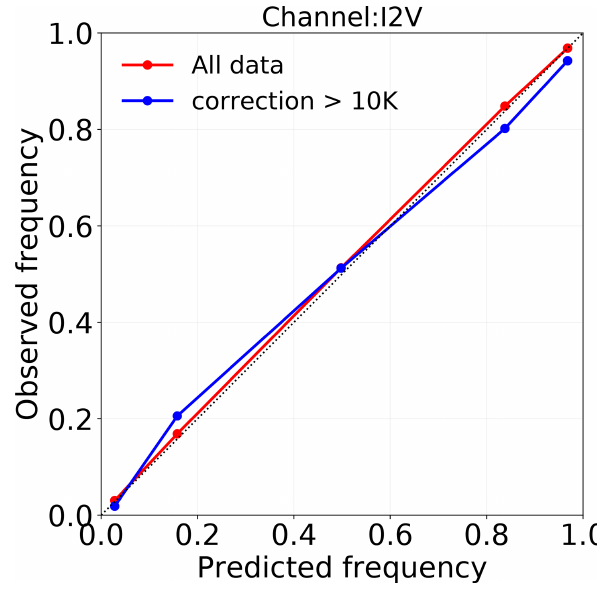
Figure 11. Same as Fig. 7 but from QRNN-single for ICI channel